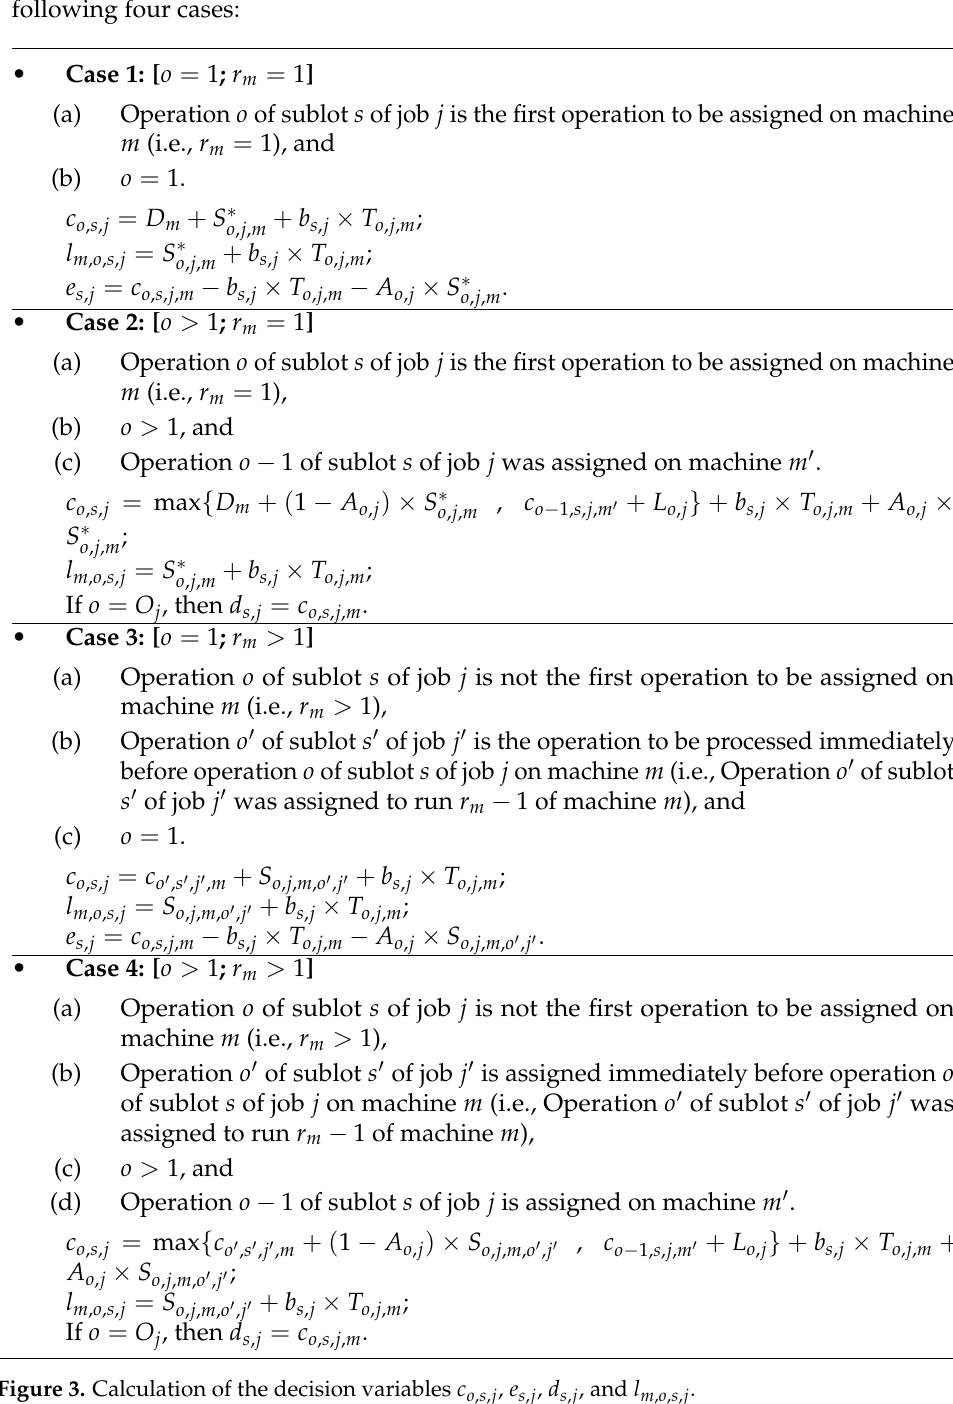
Figure 3. Calculation of the decision variables c o , s , j , e s , j , d s , j , and l m , o , s , j